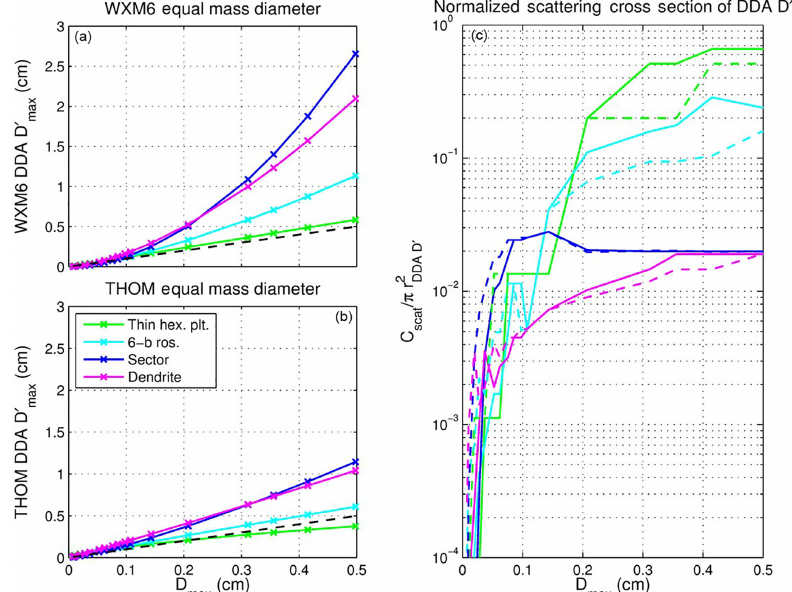
Figure 6. (a, b) The corresponding equal mass DDA habit size calculated from Eq. (3) for WRF (a) WSM6, WDM6 and (b) THOM schemes. (c) The normalized scattering cross sections of the equal mass DDA sized habits ( D (cid:48) max ) as a function of D max at 150GHz and at 263K for the WSM6/WDM6 (solid lines) and the THOM scheme (dashed